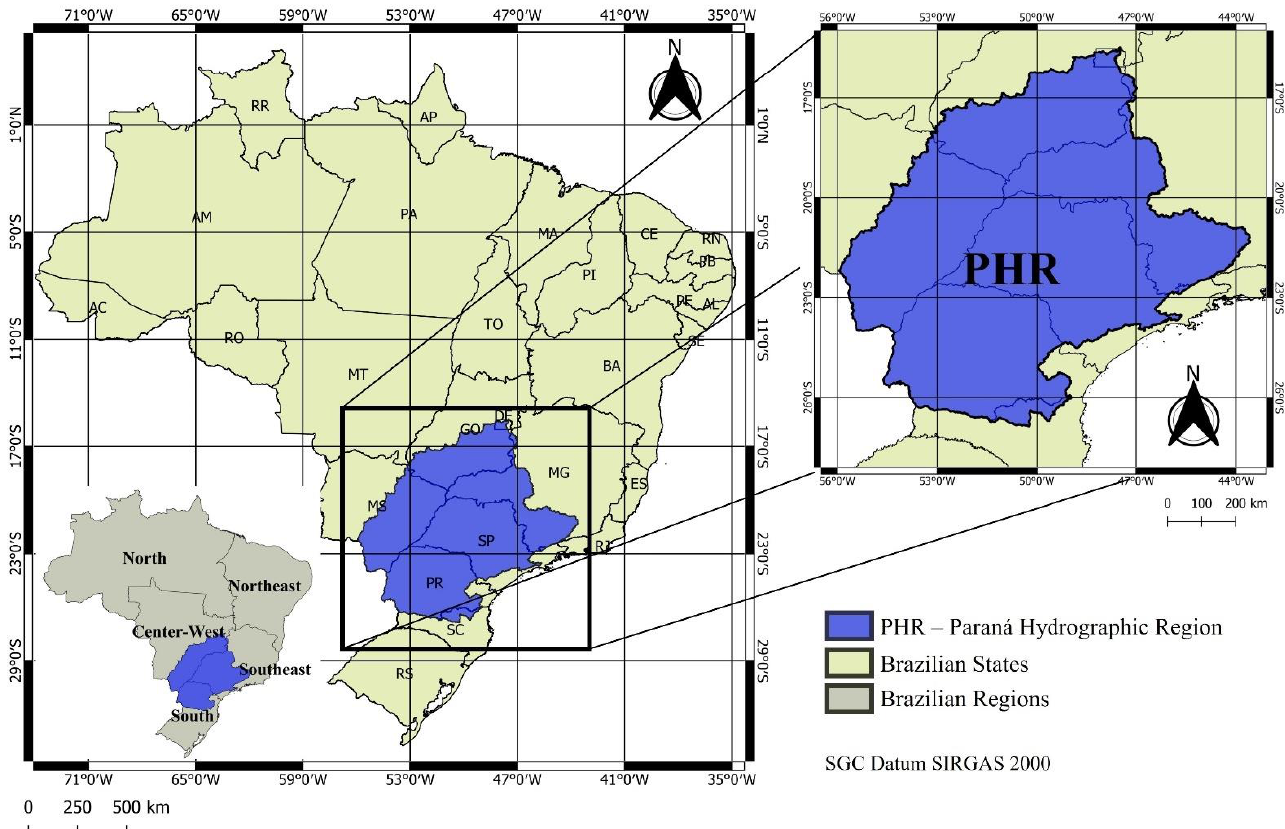
Figure 1. Representation of the study area: on the left side is the location of the PHR inside Brazil, and on the right side, a zoom on the region.